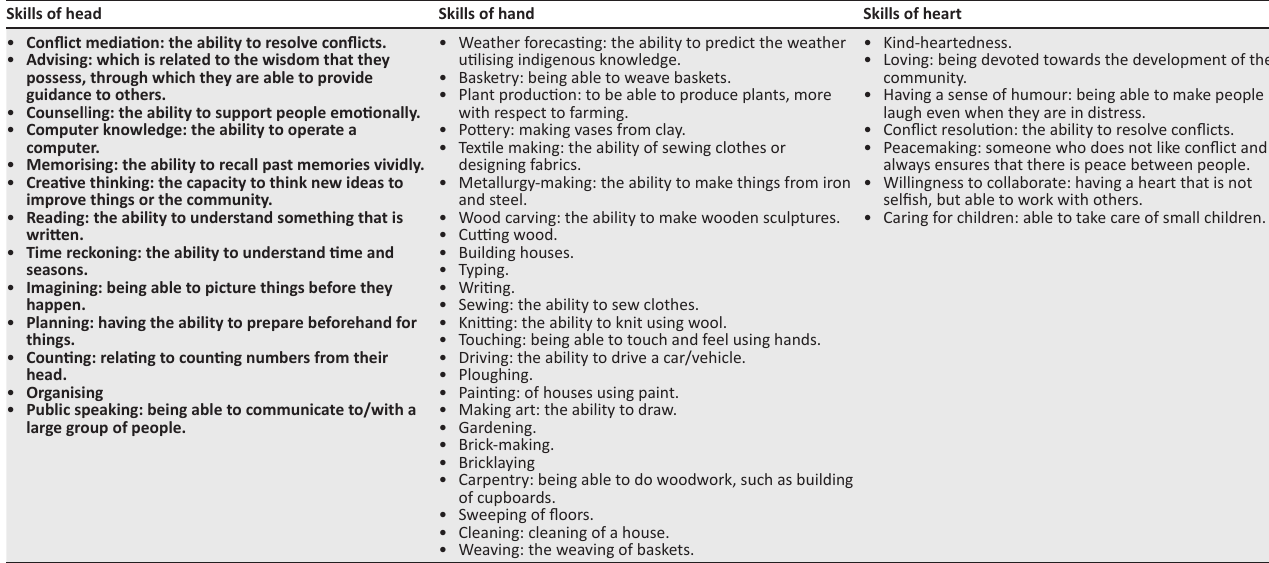
TABLE 2: Community skills and assets of the affected community members that can be utilised in disaster management. Skills of